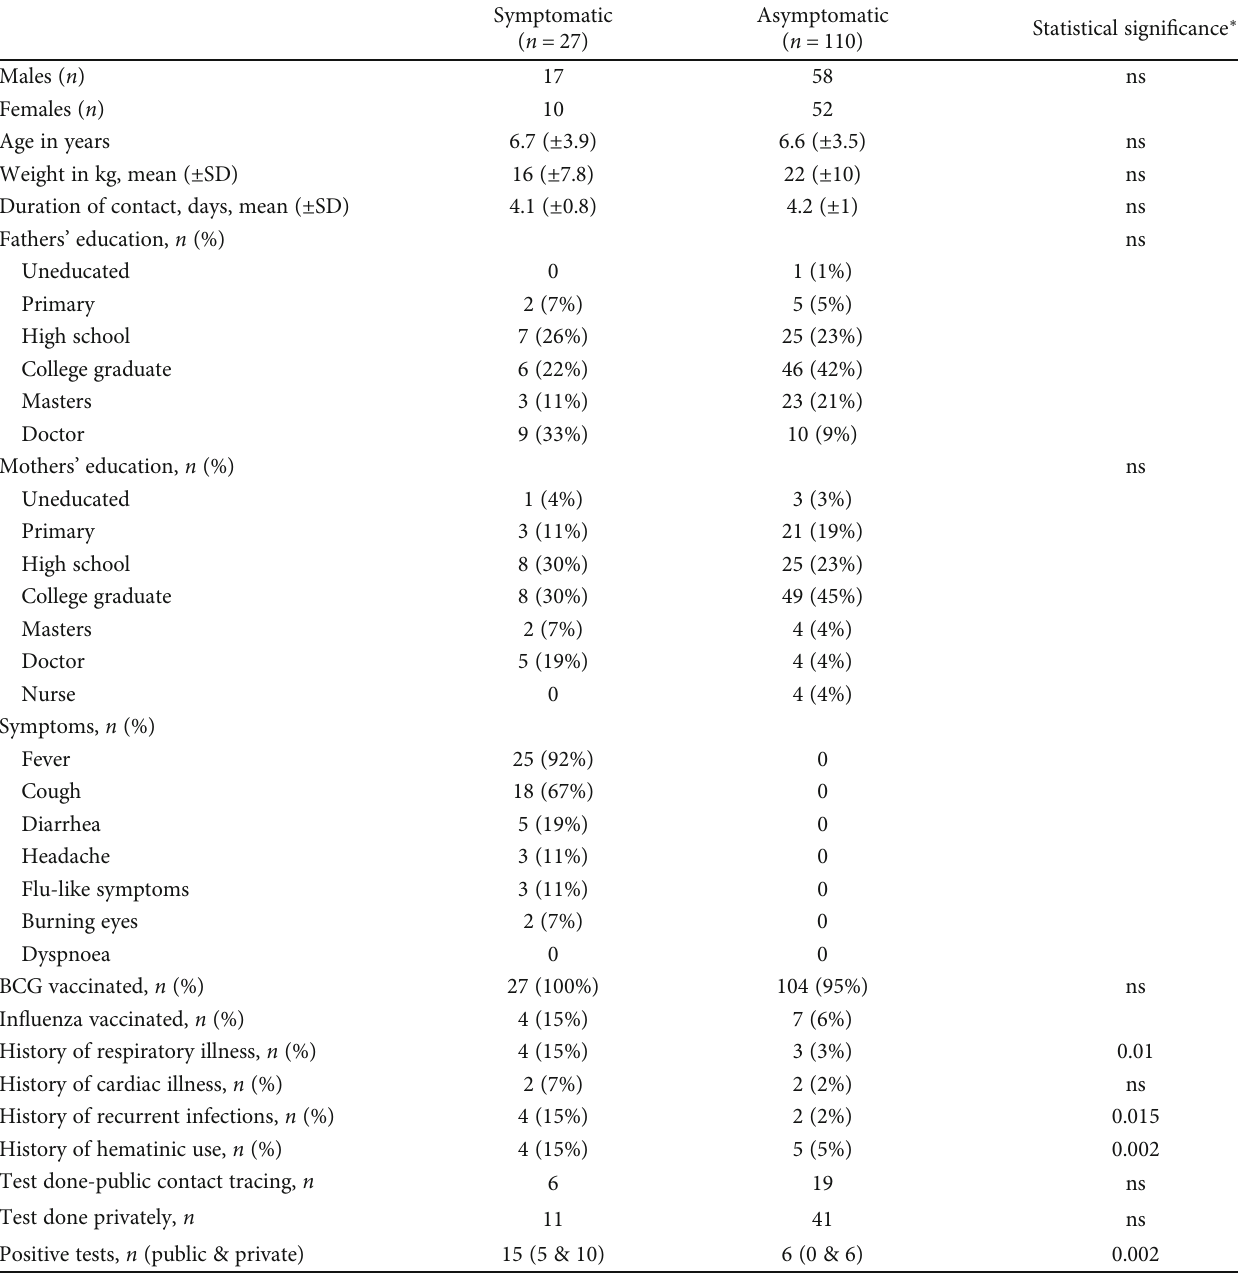
Table 2: Characteristics of the paediatric contacts and the risk factors associated with development of